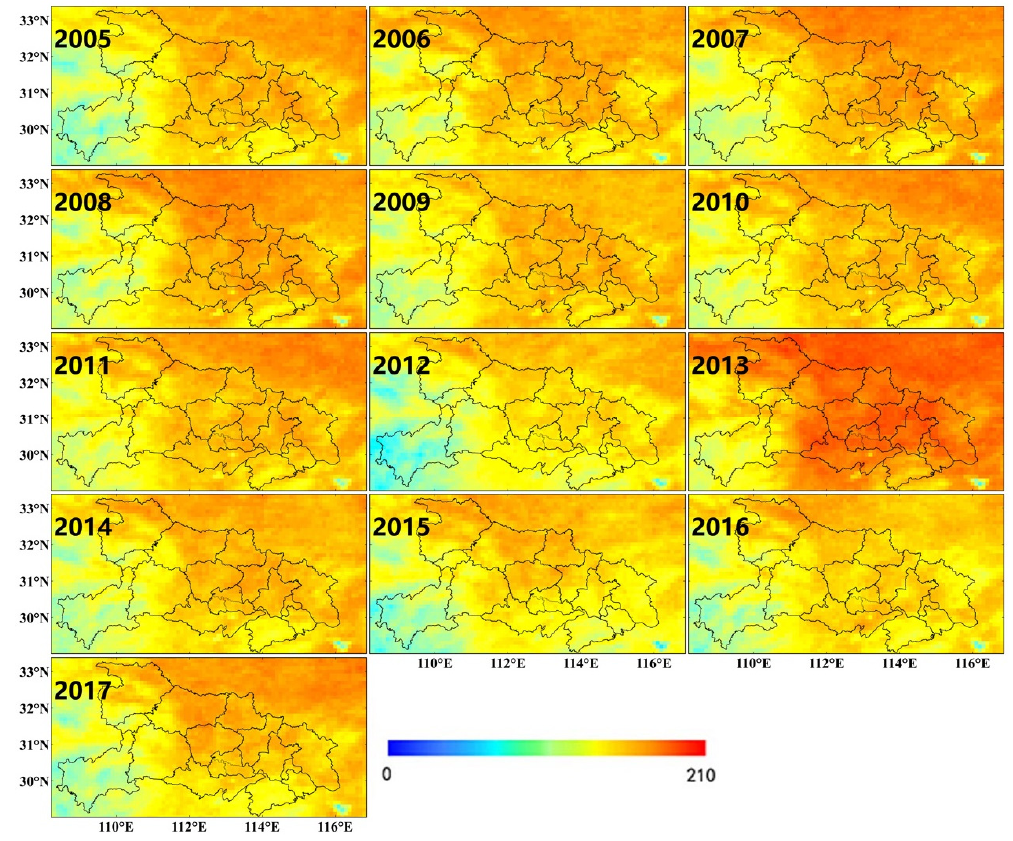
Figure 9. Annual retrieval frequency of MODIS AOD over Hubei province during 2005–2017.